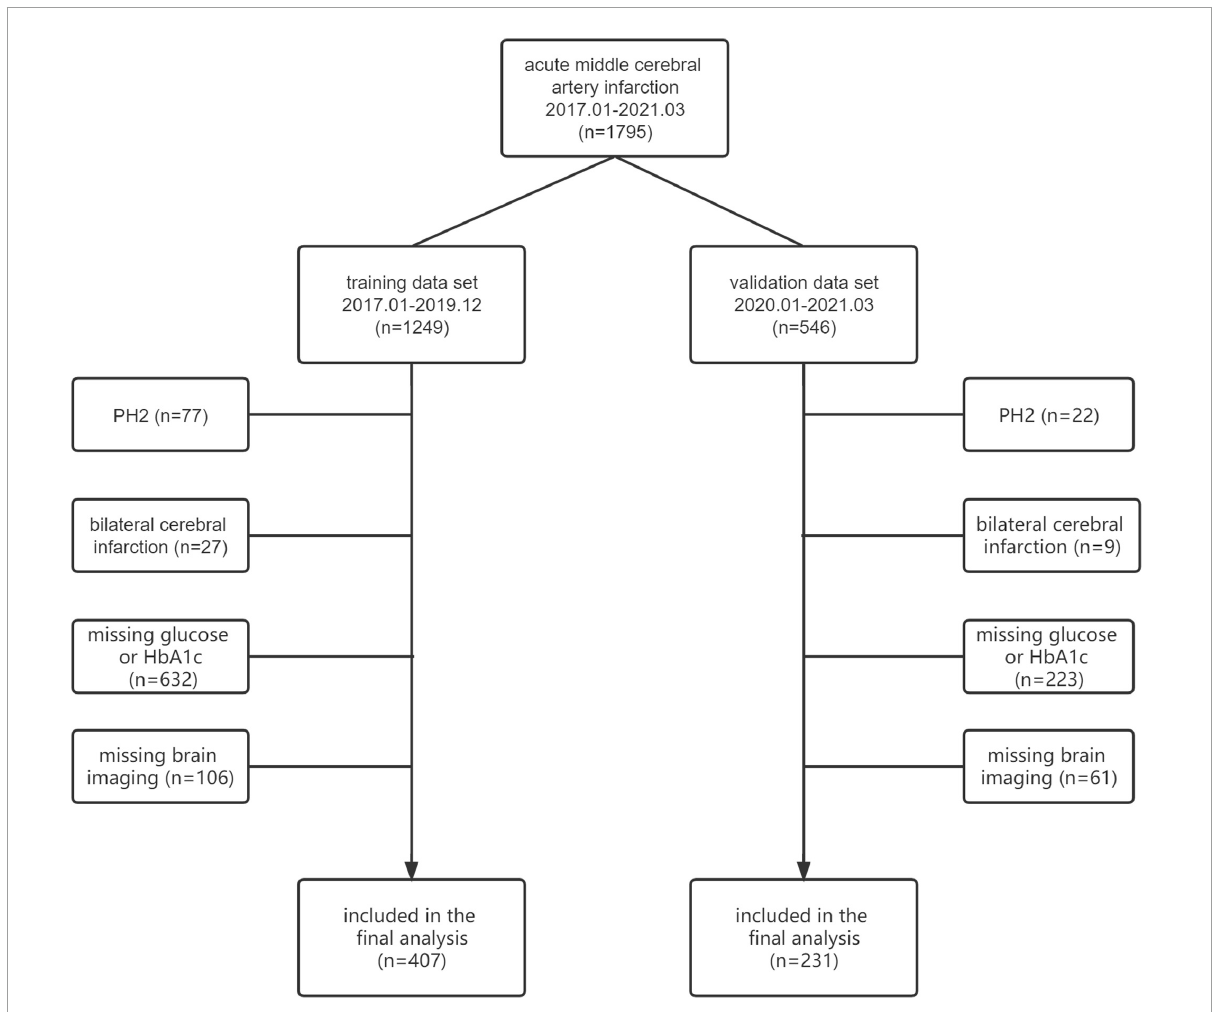
FIGURE1 Flowchart of the screening of patients. PH, Parenchymal hemorrhage; HbA1c, hemoglobin A1c.